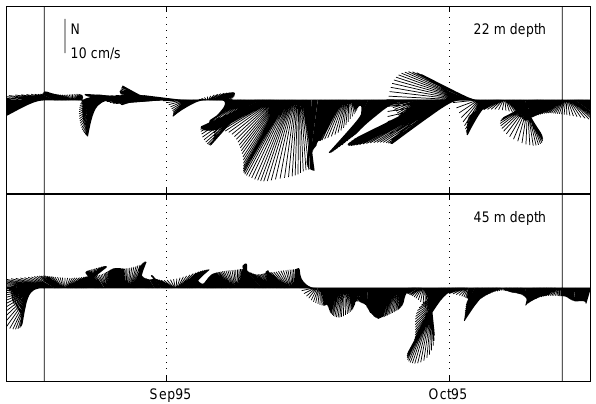
Fig. 5. Low-pass component for surface (top) and bottom (bottom) current-meters at station